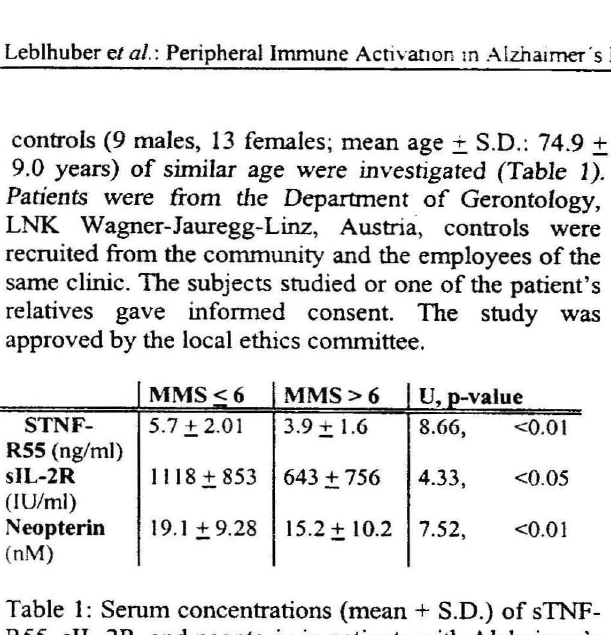
Table 1: Serum concentrations (mean + S.D.) of sTNF R55, sIL-2R, and neopterin in patients with Alzheimer's disease separated into two groups with higher (> 6, n = 34) and lower mini-mental-score (MMS :s 6, n = 20).